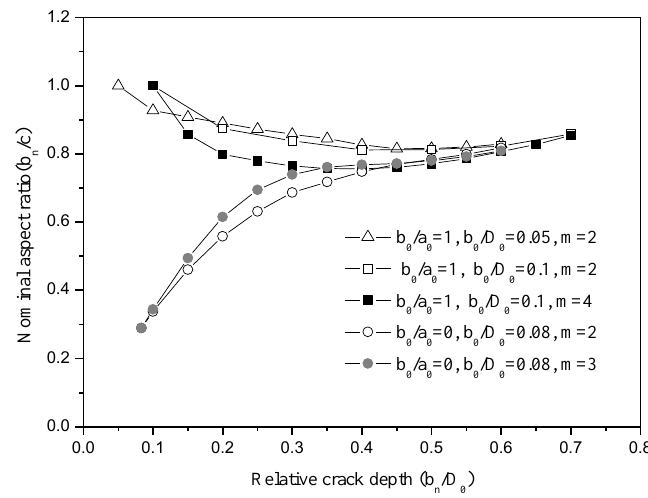
Figure 9. Nominal aspect ratio vs. relative crack depth.